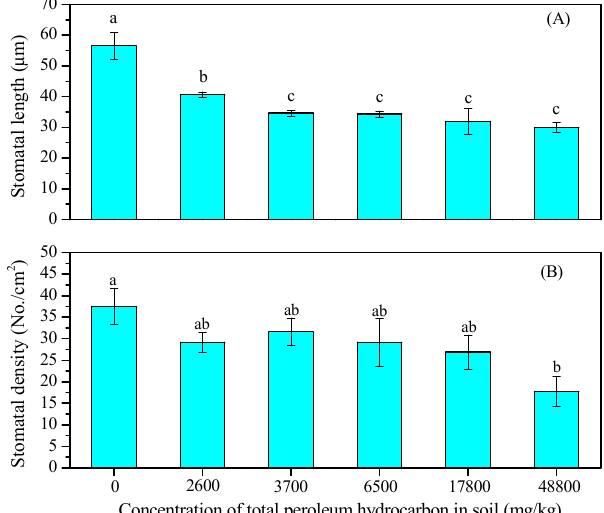
Figure 2. Effect of soil contamination with crude oil on stomatal length ( A ) and stomatal density ( B ) of maize leaf. ( p < 0.05). Different letters on top of the bar indicate they are significantly different at p < 0.05.